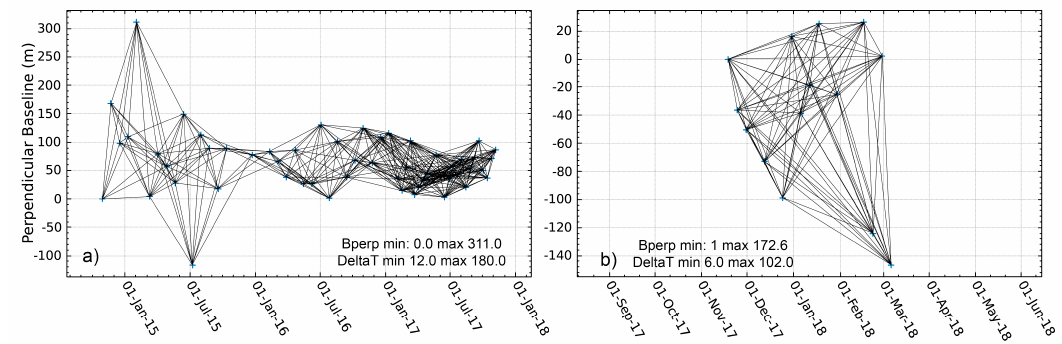
Figure 4. The perpendicular baseline network for a small baseline subset (SBAS) time series ( a ) before the earthquake and ( b ) after the earthquake.